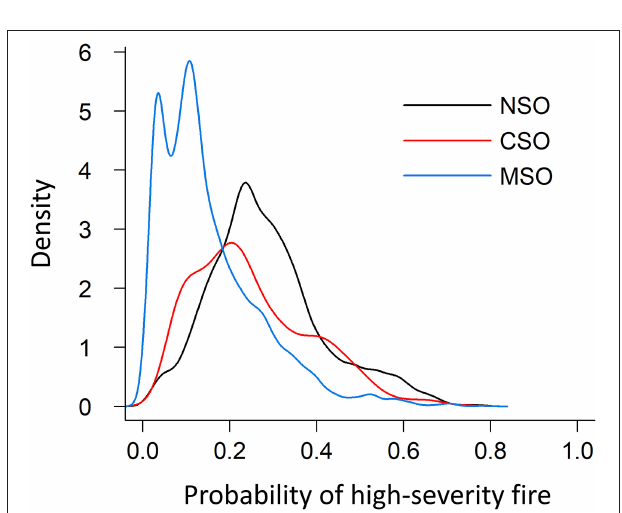
FIGURE 6 | Kernel density estimation of high-severity fire probability distribution within the ranges of three spotted owl subspecies. NSO, Northern spotted owl; CSO, California spotted owl; MSO, Mexican spotted owl.